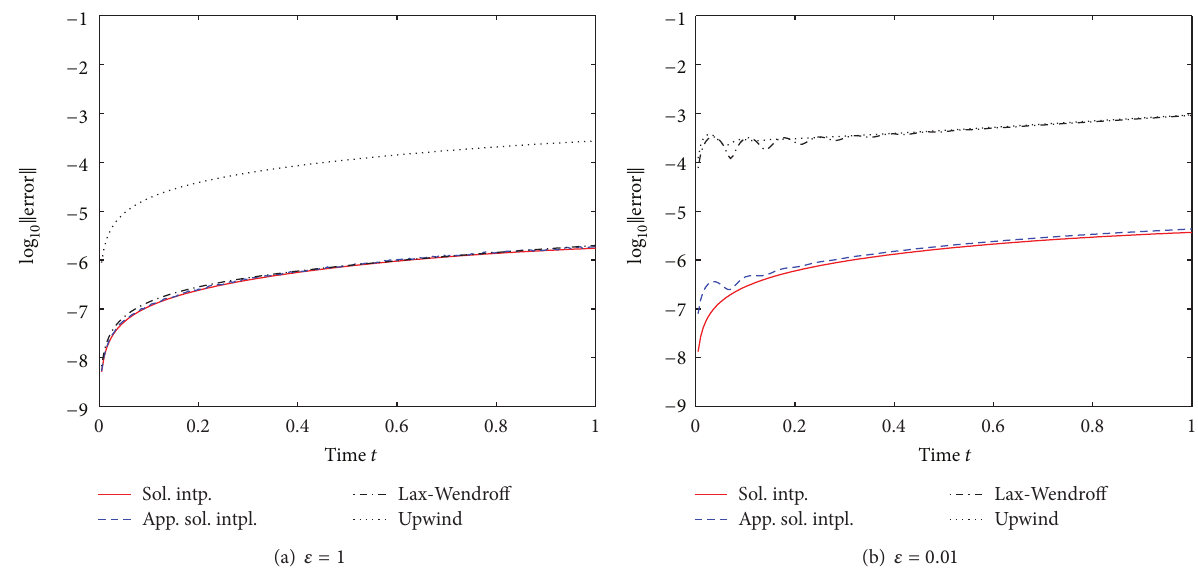
Figure3:Numericalsolutionsfor 𝑢 𝑡 +𝑎𝑢 𝑥 = sin (𝑥/𝜀)𝑢 :asolution 𝑢 = exp (−𝜀 cos (𝑥/𝜀)−𝑥+𝑡)√(𝑥 − 𝑡) 2 + 1 isusedtogenerateinitial/boundary conditions and measure errors.